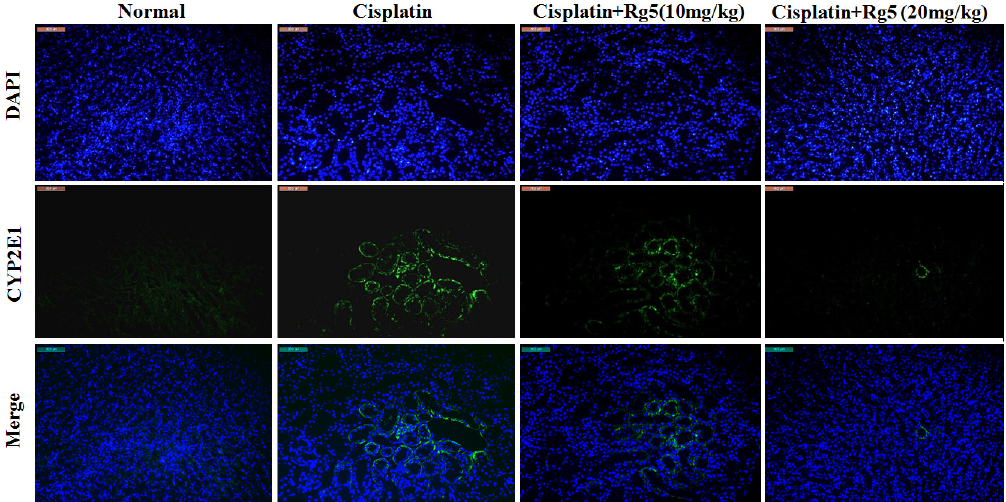
Figure 4. Effects of ginsenoside Rg5 on the expression of cytochrome P450 E1 (CYP2E1). The expression level of CYP2E1 ( green ) in tissue section isolated from different groups was assessed by immunofluorescence. Representative immunofluorescence images were taken at 400×. 4 ′ ,6 ‐ Diamidino ‐ 2 ‐ phenylindole (DAPI) ( blue ) was used as a nuclear counterstain.